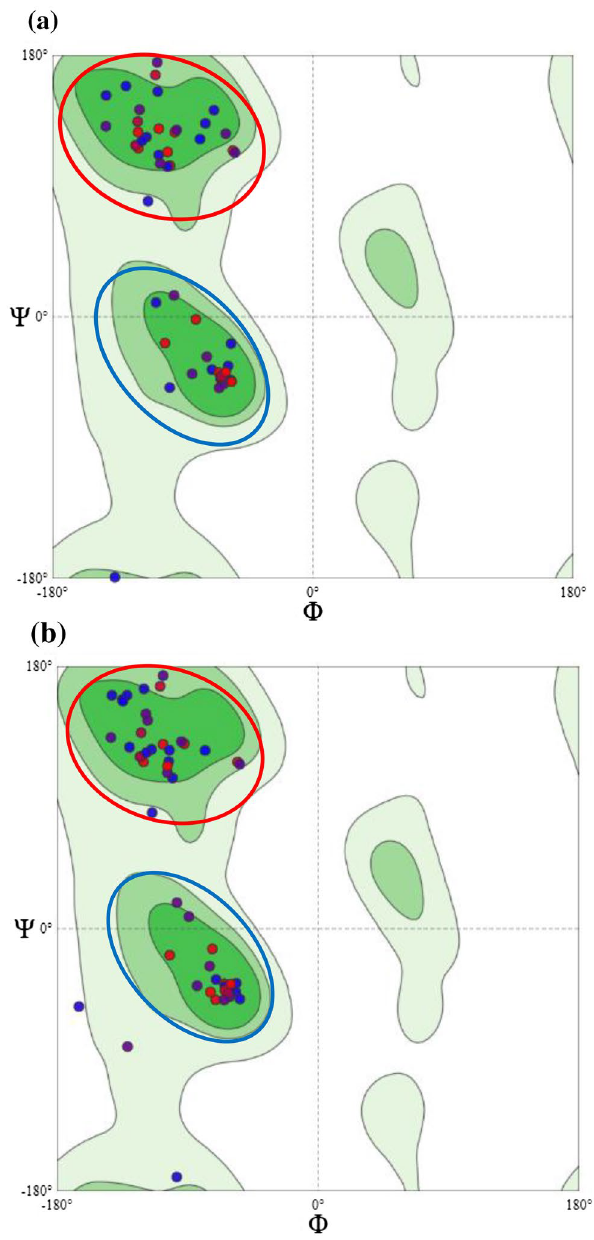
Figure 3. Ramachandran plot showing hydrophobic residues for ( a ) 2B64I-ANLF3/2018 and ( b ) 2B64I- ANLF5/2018. Ramachandran plot was obtained by using SWISS-MODEL (https:// swiss model. expasy. org/). The red circle refers to hydrophobic residues in the β-sheet. The blue circle denotes the hydrophobic residues in right-handed helix. Residues outside the circles represent residual